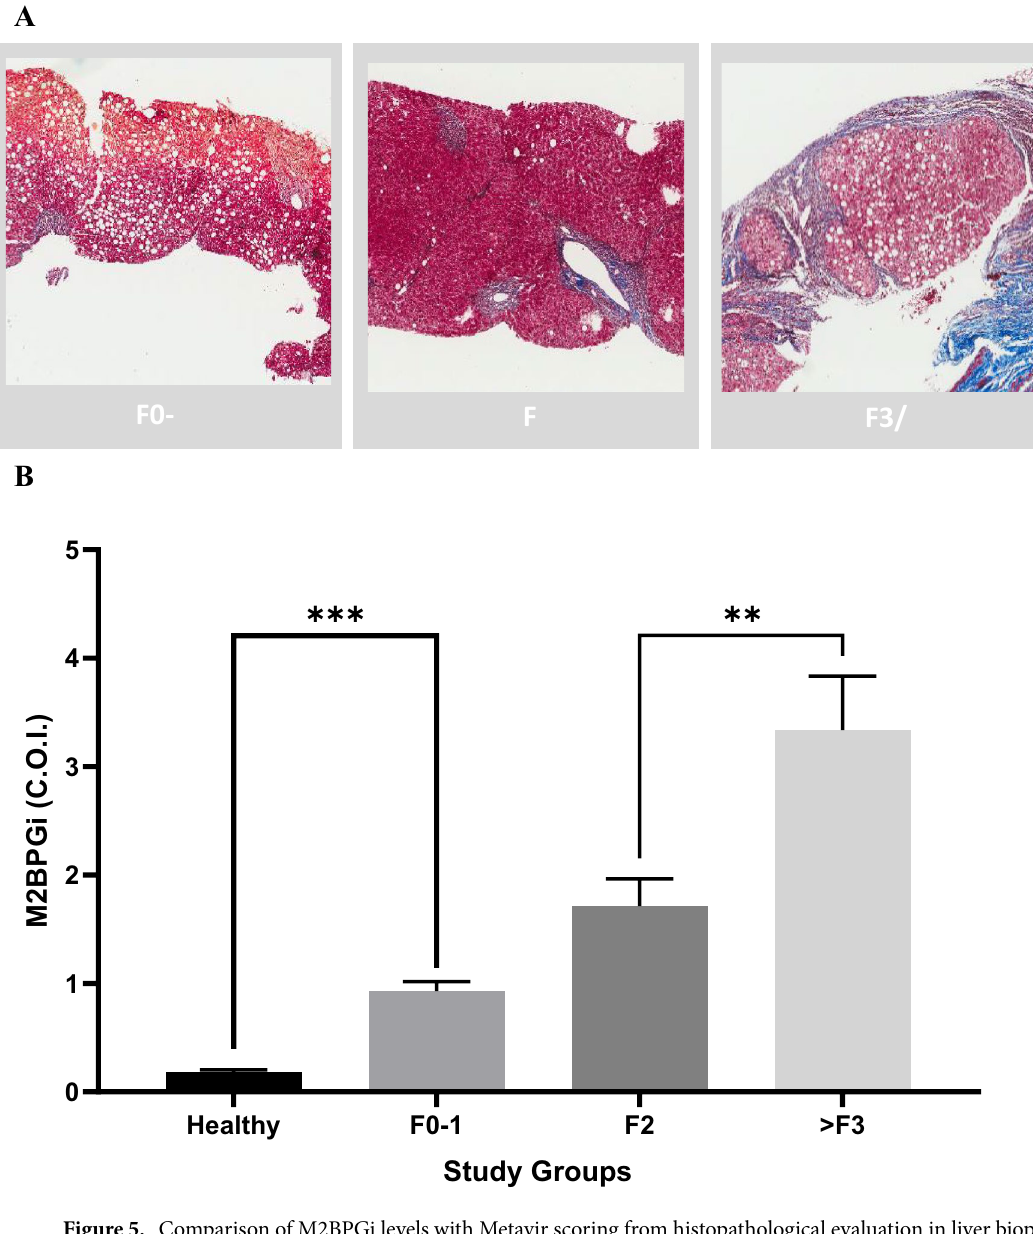
Figure 5. Comparison of M2BPGi levels with Metavir scoring from histopathological evaluation in liver biopsy of patients. ( A ) Representative histological images of F0-1 (no fibrosis), F2 (enlargement of the portal tract with rare septa formation) and F3/4 case (cirrhosis). ( B ) Corresponding average levels in each study group. SEM plotted. Kruskal Wallis one-way ANOVA shows significant differences among study groups. A